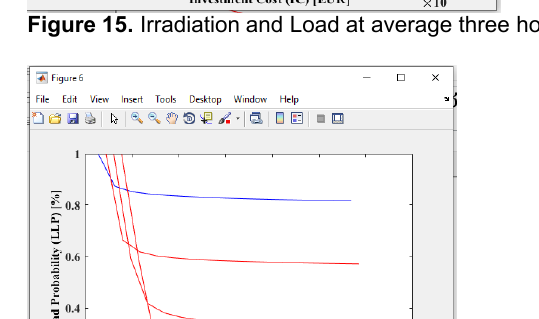
Figure 12. Irradiation and Load at average day with Loss Probability